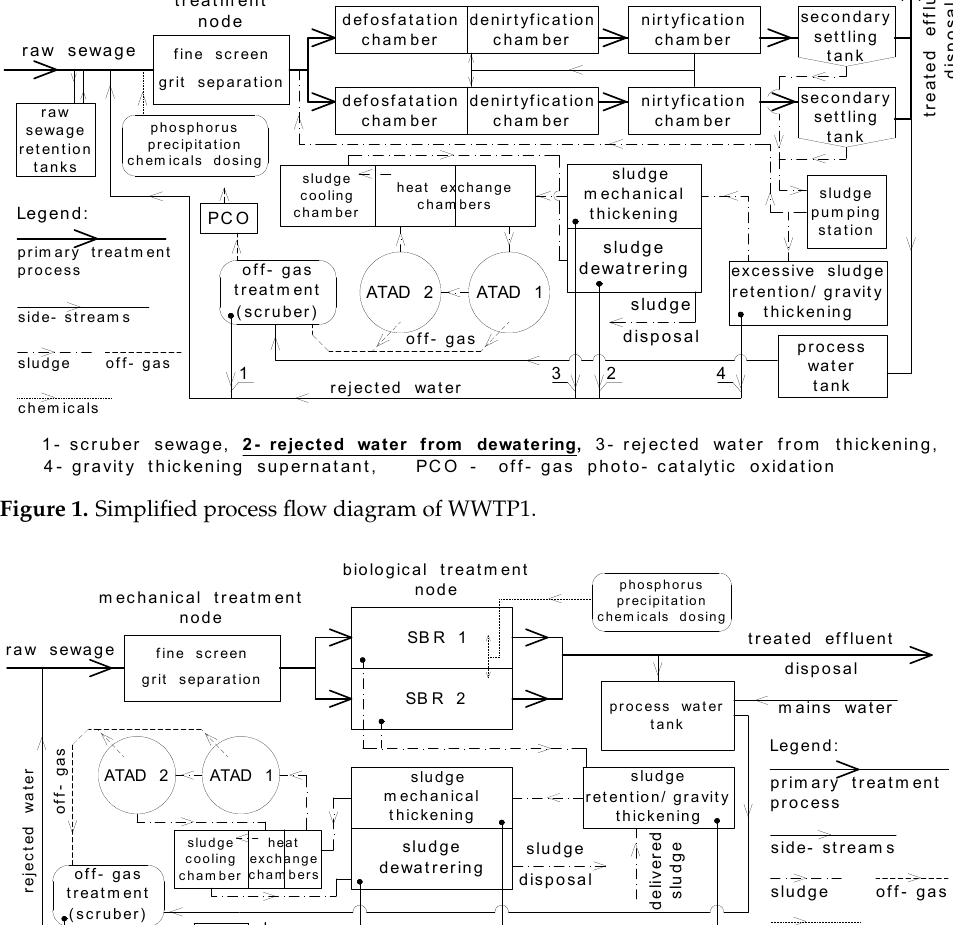
Figure 1. Simplified process flow diagram of WWTP1.